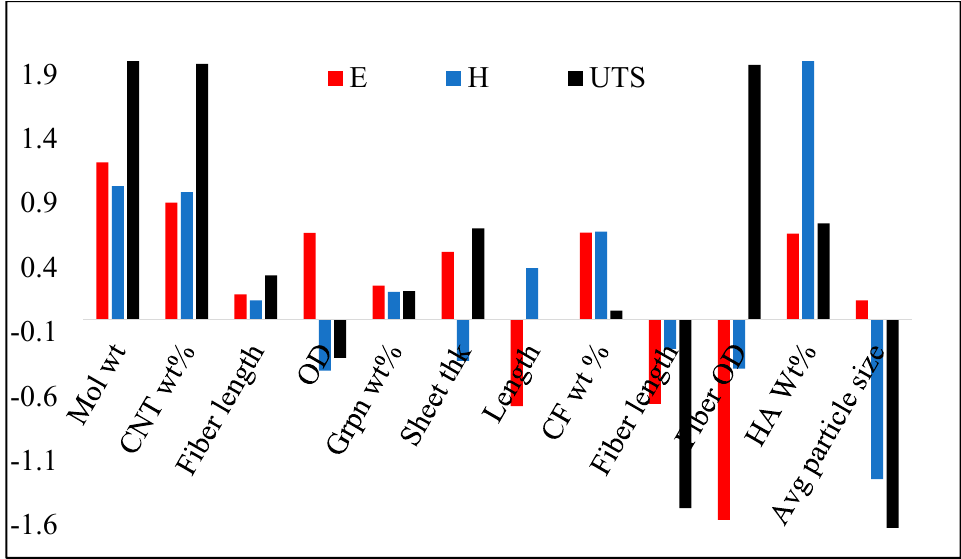
-1.6-1.1 Figure 4. Sensitivity analysis for UTS, H, and E. Figure 4. Sensitivity analysis for UTS, H, and